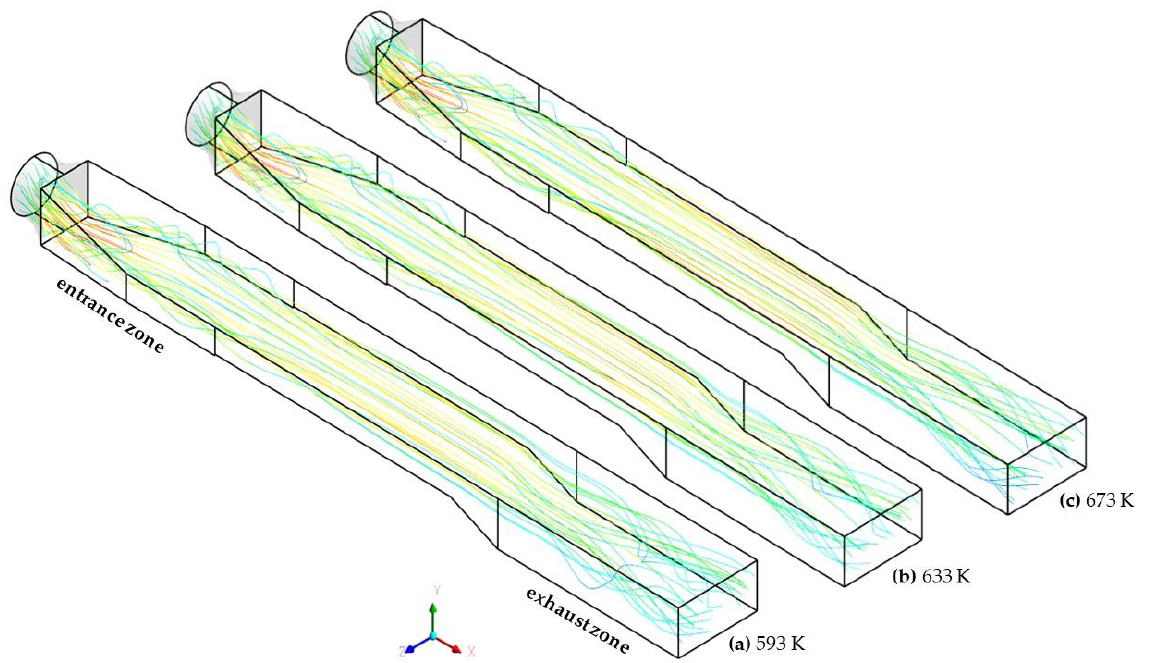
Figure 6. The streamline of gas flow inside the horizontal reactor at the deposition temperature of ( a ) 593 K; ( b ) 633 K and ( c ) 673 K.